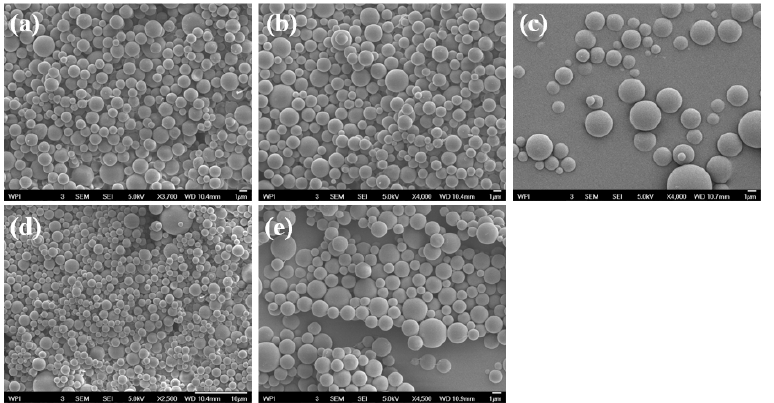
Figure 1. SEM pictures of PLGA-CS-PEG microsphere formulations: ( a ) PLGA-CS-PEG_PGS5, ( b ) PLGA-CS-PEG_PGS8, ( c ) PLGA-CS-PEG, ( d ) PLGA-CS-PEG_PTX5, and ( e ) PLGA-PEG_PTX8 microspheres.